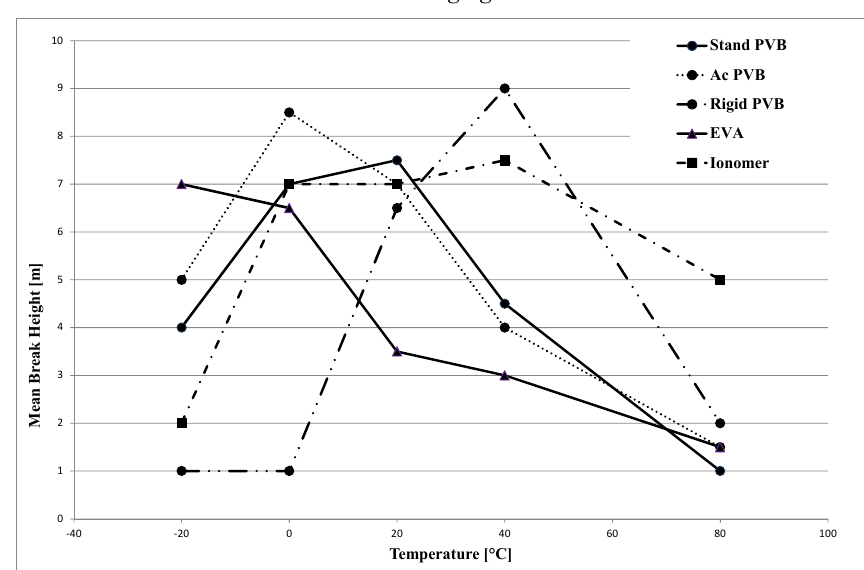
Fig. 10 Mean Break Height (MBH) of laminated interlayers at different temperatures